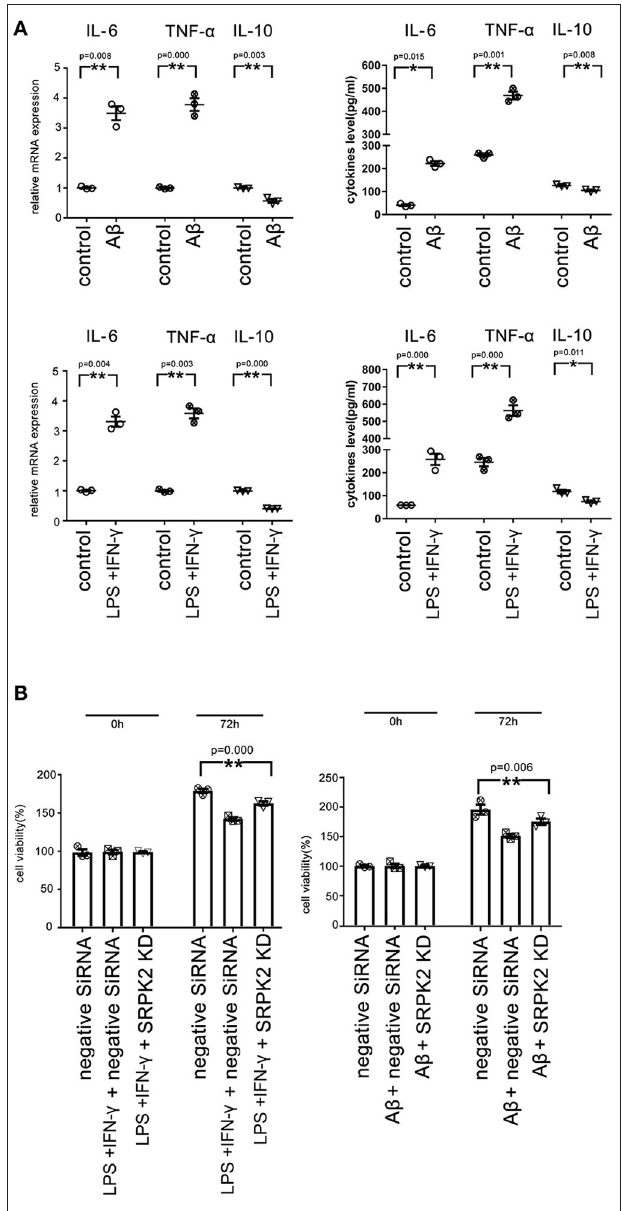
FIGURE 6 | Both the A β and LPS + IFN- γ can promote the cytotoxicity of the BV2 cells via the expression of SRPK2. The BV2 cells with/without SRPK2 expression (by transfection of SRPK2 recombinant lentiviral vectors or knockdown of SRPK2 by transfection of siRNA) were stimulated by A β or LPS + IFN- γ for 24h, while the control cells were treated with DMSO (control for A β ) or PBS (control for or LPS + IFN- γ ). The cells and culture medium for each were collected. (A) The total RNA was extracted from the cells and the mRNA levels of the cytokines of the cells were examined by real-time qPCR. The cytokine levels in the culture medium were examined by ELISA. The results showed that treatment with LPS + IFN- γ or A β can increase the levels of IL-6 and TNF- α , but decrease the level of IL-10 at mRNA and protein levels compared to the controls, respectively. (B) The culture medium was collected and used to treat HT-22 cells for 48h. Cell viability of HT-22 cells was evaluated by the WST-1 assay. Our data showed that the BV2 cells stimulated by A β or LPS +